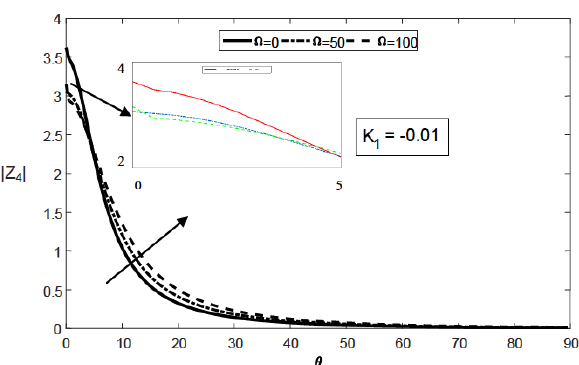
medium is set on rotation with constant angular frequency Ω . The response of the curves representing the amplitude ratio for second wave is exactly same as that of first wave but with different intensity.